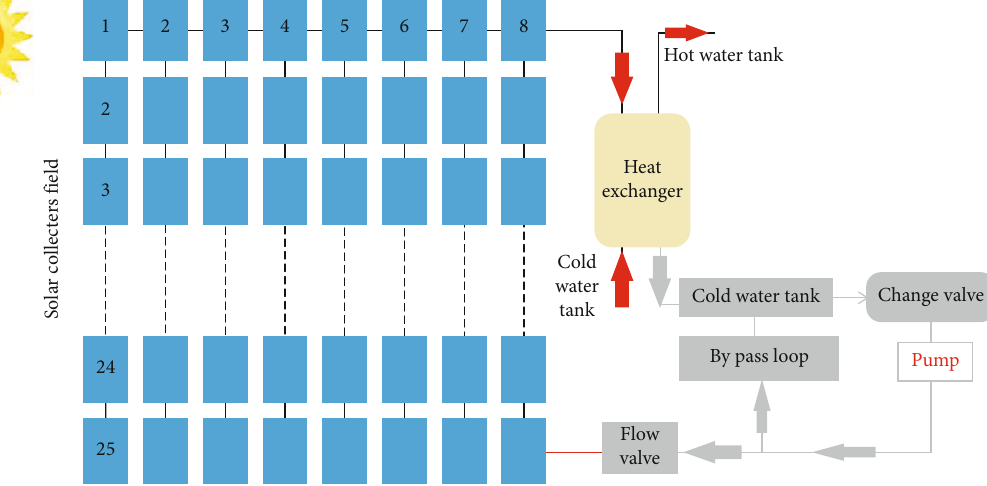
Figure 8: Schematic of solar absorption cooling system.